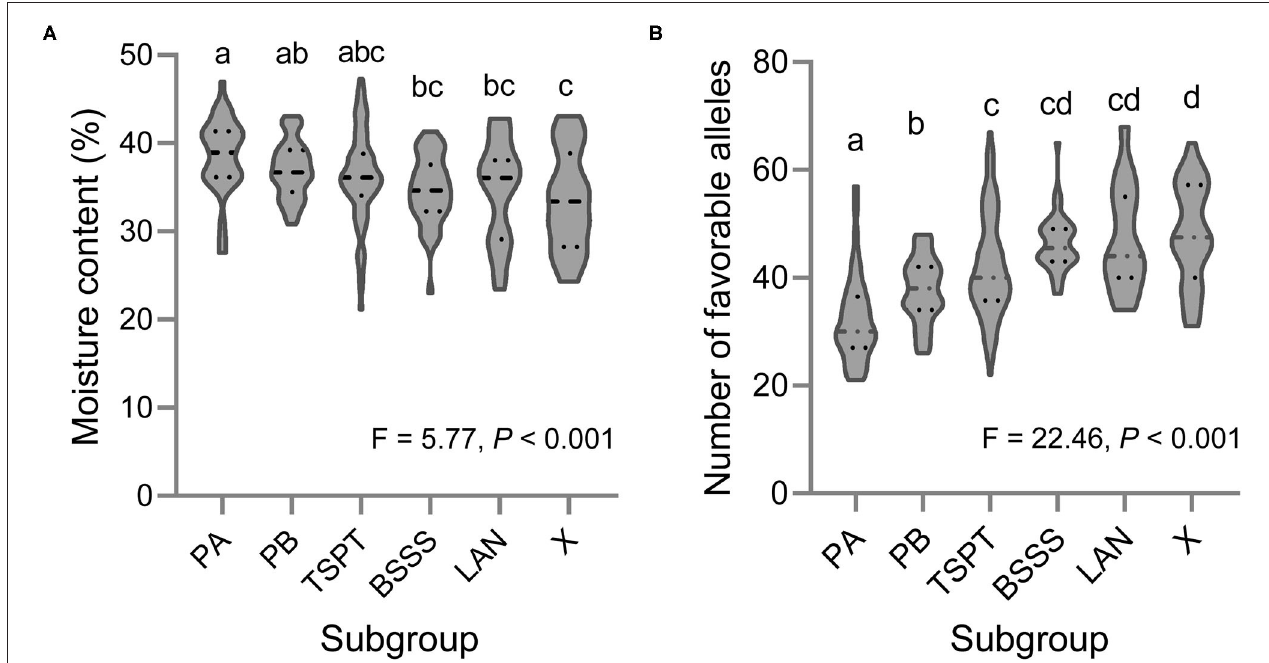
FIGURE 4 | Violin plot of (A) the KMC and (B) the number of favorable alleles for KMC in six subpopulations of this association mapping panel. Different letters indicate significant difference at P < 0.001 estimated by Student’s t